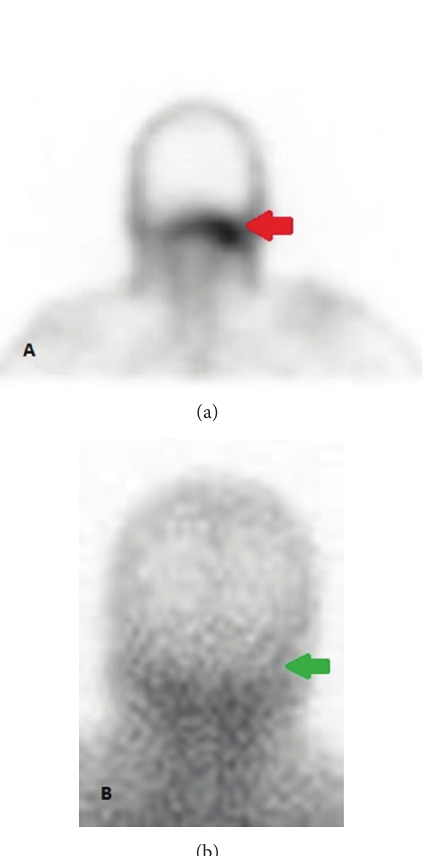
Figure 4: (a) The Gallium-67 scan before the treatment confirms the diagnosis of left SBO (red arrow). (b) The repeated Gallium-67 scan shows the resolution of the left SBO (green